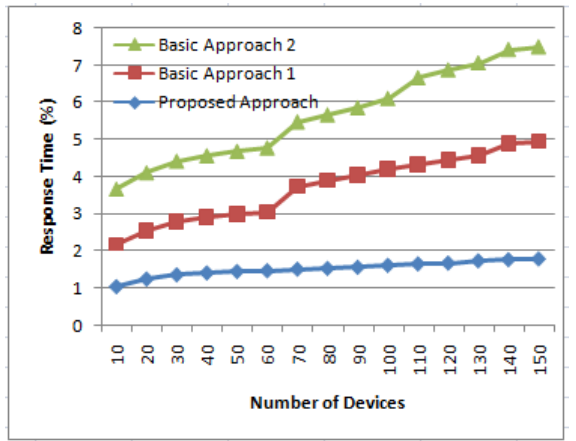
Figure 7. Response Time.